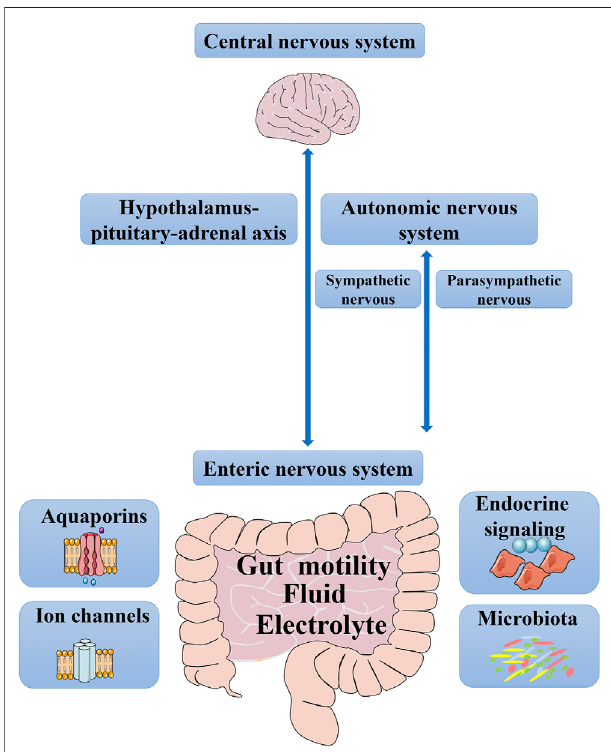
FIGURE 1 | Factors that control gut motility, fl uid and electrolyte. From top to bottom, it encompasses the central nervous system, the sympathetic and parasympathetic branches of the autonomic nervous system, hypothalamus-pituitary-adrenal axis, the enteric nervous system, endocrine signaling, microbiota, aquaporins, and ion